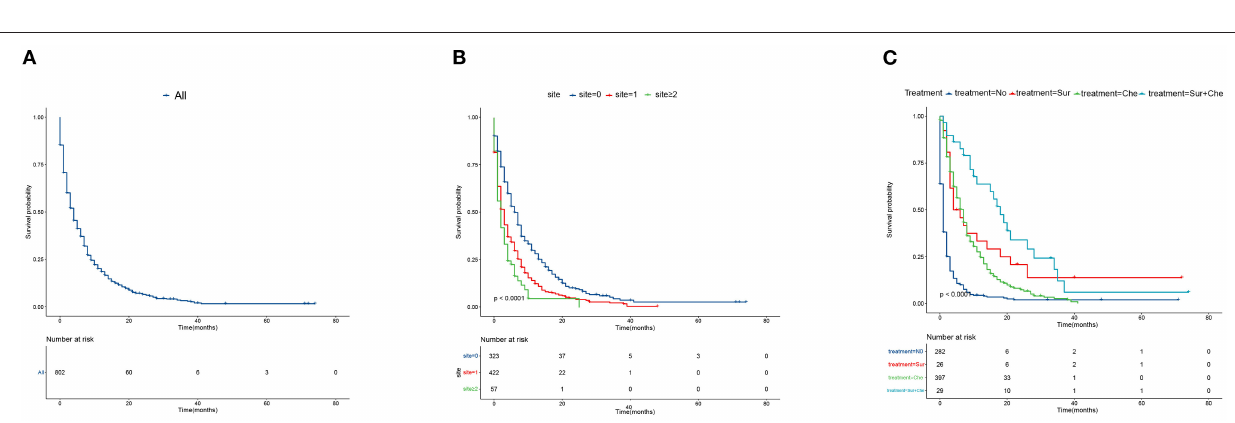
Frontiers in Public Health |